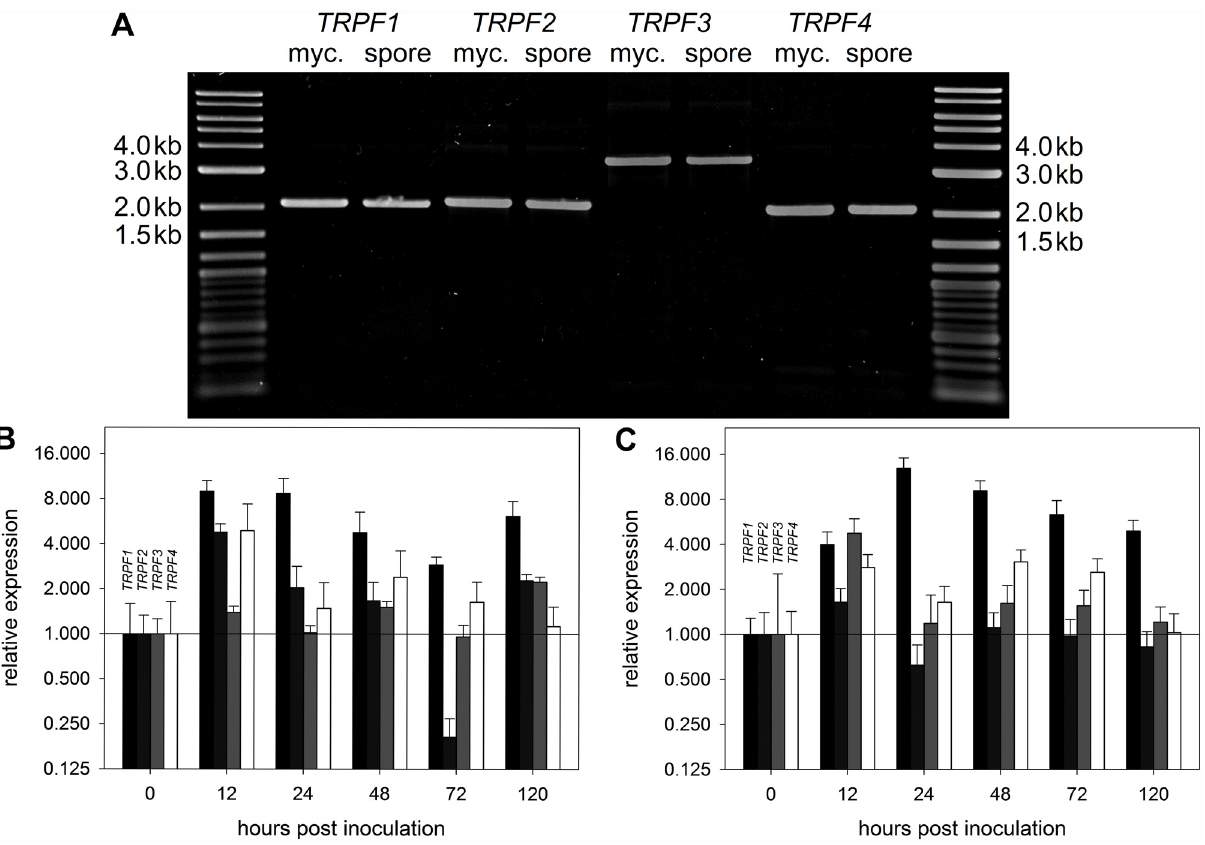
Fig 3. Expression profiles of the CgTRPF genes in axenic culture and during infection of C . graminicola on maize. (A) Full-length cDNA of CgTRPF genes was amplified from RNA extracted from in vitro grown mycelium and spores. Products were expected at 2098, 2152, 3522, and 2101 bp for CgTRPF1 , CgTRPF2 , CgTRPF3 , and CgTRPF4 , respectively. (B, C) Expression during the infection process relative to the expression in spores (0 hours post infection, hpi); black: CgTRPF1 , dark grey: CgTRPF2 , light grey: CgTRPF3 , white: CgTRPF4 . (B) Detached third leaves of 2.5-week-old drop-infected plants (cv. Mikado); assayed by qRT-PCR. Data are means ± SE (N = 3). (C) Third leaf of intact two-week-old drop-infected plants (cv. Golden Jubilee); assayed by RNA-Seq. Data are means ± SE (N = 3).